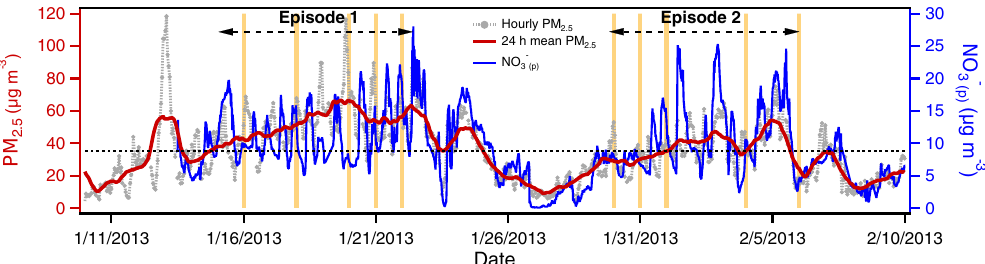
Figure 1. Time series of surface PM 2 . 5 concentration (µgm − 3 ) measured in Fresno during the DISCOVER-AQ campaign for 1h averages (light red dotted line) and for a running average (red line, smoothed over 24h), along with the 1h average NO − line). The vertical orange lines indicate the days on which airborne measurements were made. The horizontal dashed black line indicates the NAAQS 24h standard of 35µgm − 3 for PM 2 . 5